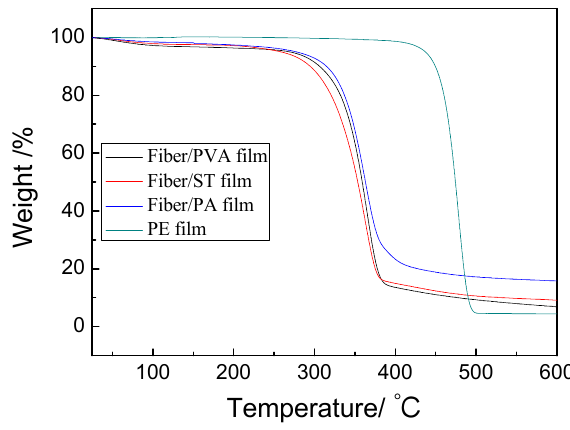
Figure 4. Thermal gravimetric analysis (TGA) curves for the four tested films.